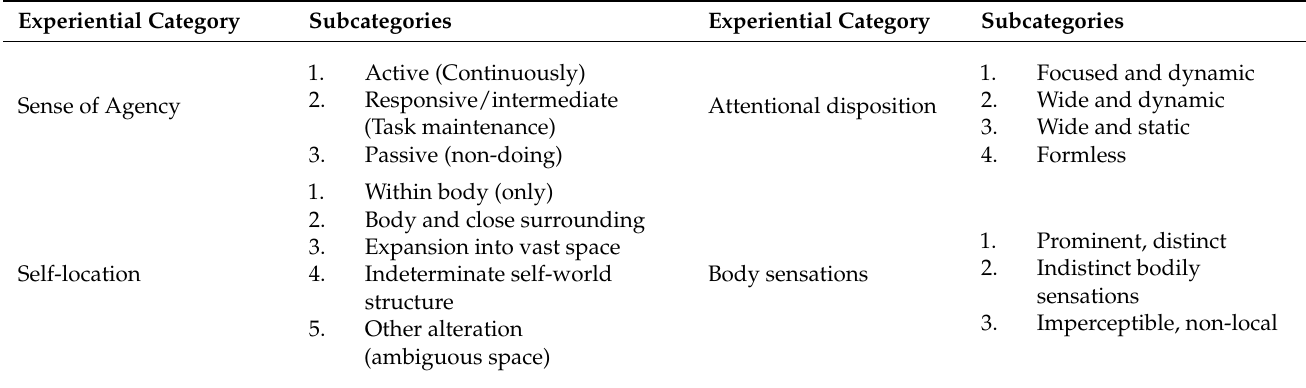
Table 1. Experiential categories used for characterization of SB states (both SB+ and SB − ). Experiential Category Subcategories Experiential Category Subcategories